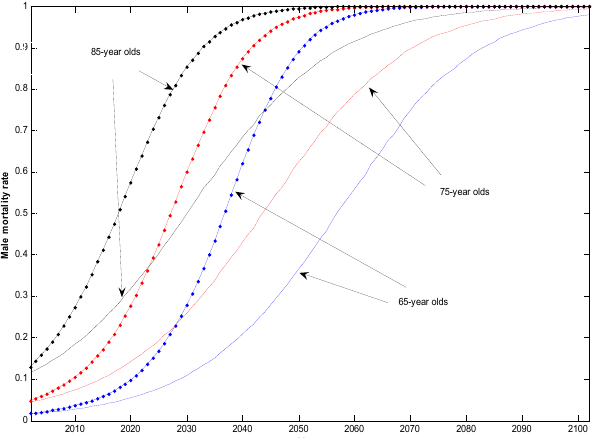
Figure 4. 90% Prediction Bounds for Male Mortality Rates. Notes: As per the uncertain ‐ parameter fan chart in Figure 1.